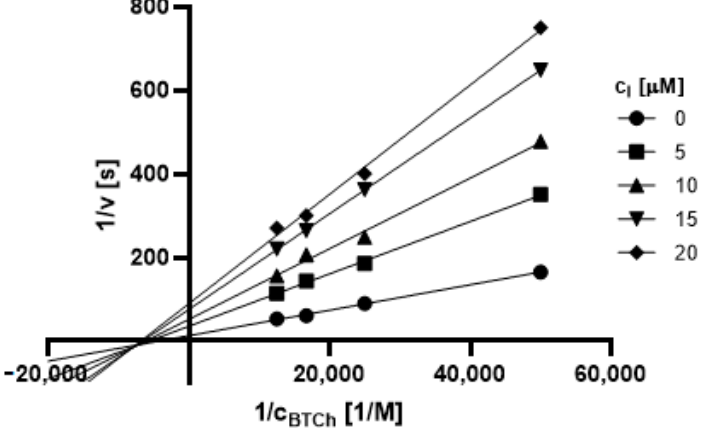
Figure 10. Lineweaver–Burk plot for 1p and BuChE inhibition (BTCh = butyrylthiocholine).